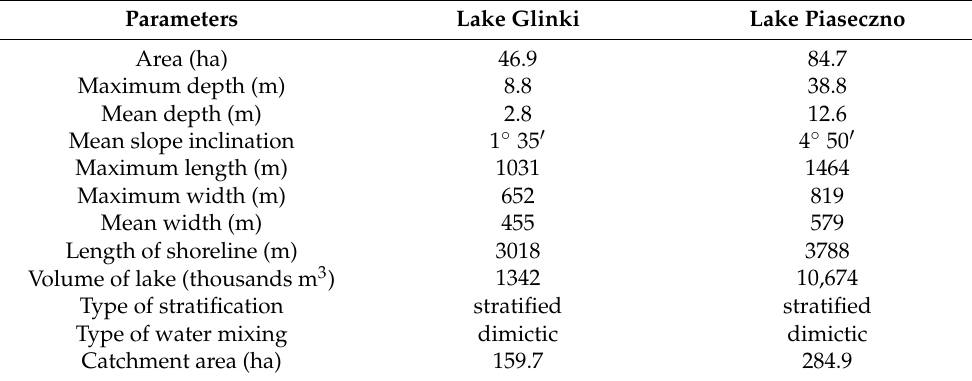
Table 1. General morphological data of the studied lakes